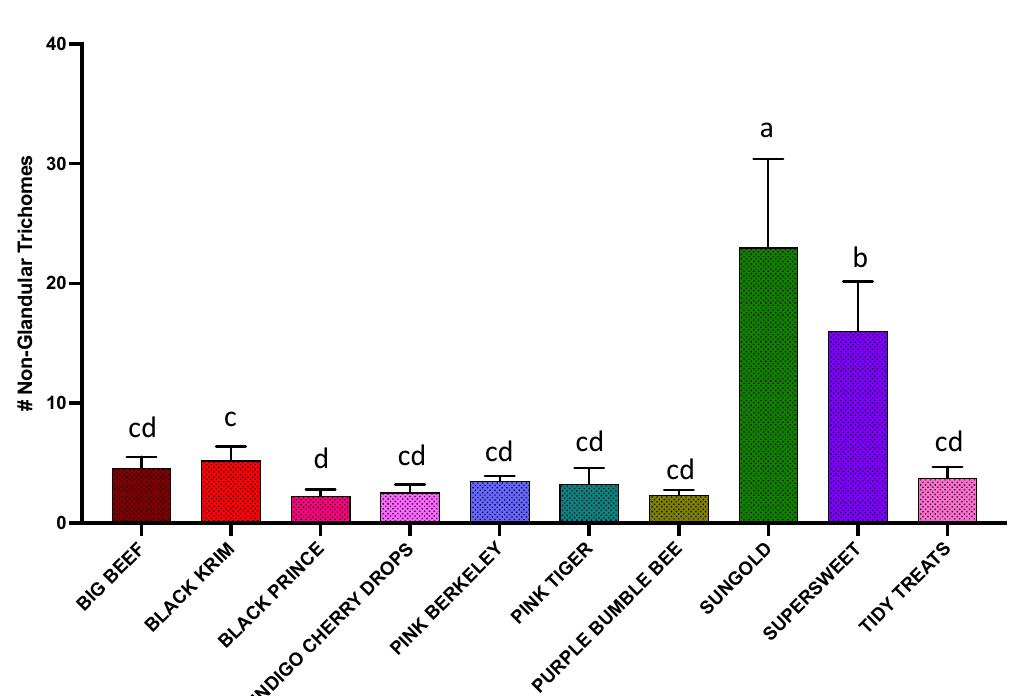
Fig. 5 The comparison of total number of non-glandular trichomes present in ten varieties of